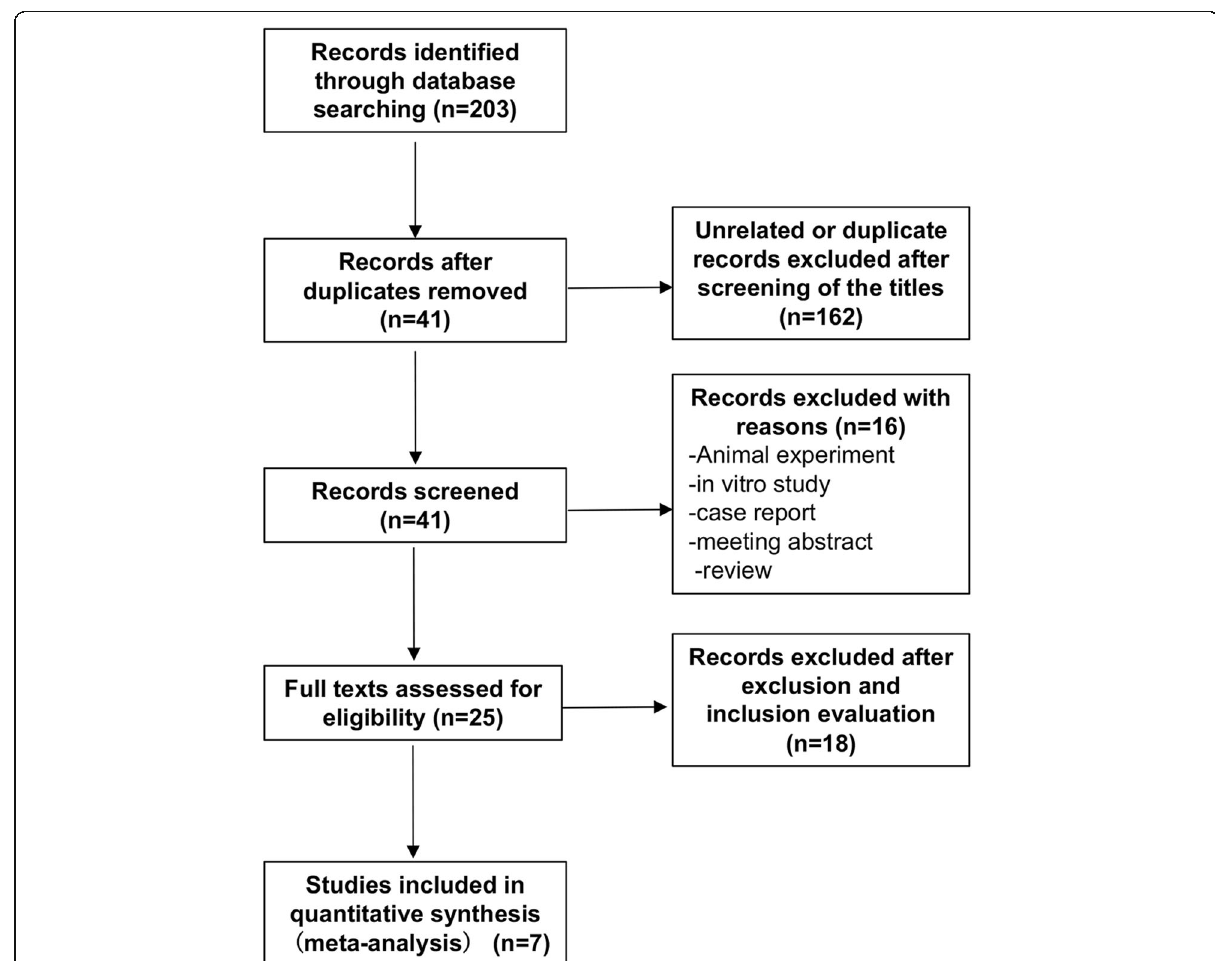
Fig. 1 Flow diagram detailed procedures of selecting eligible